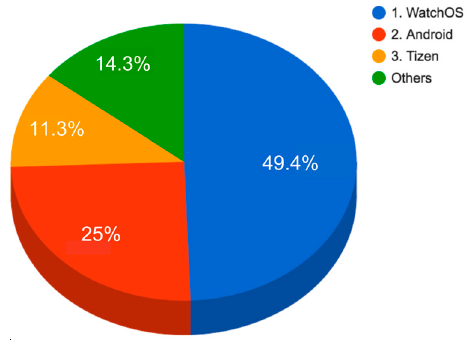
Figure 2. 2016 smartwatch OS prediction in the wrist wearable sector by IDC Research Inc. Adapted from [32].